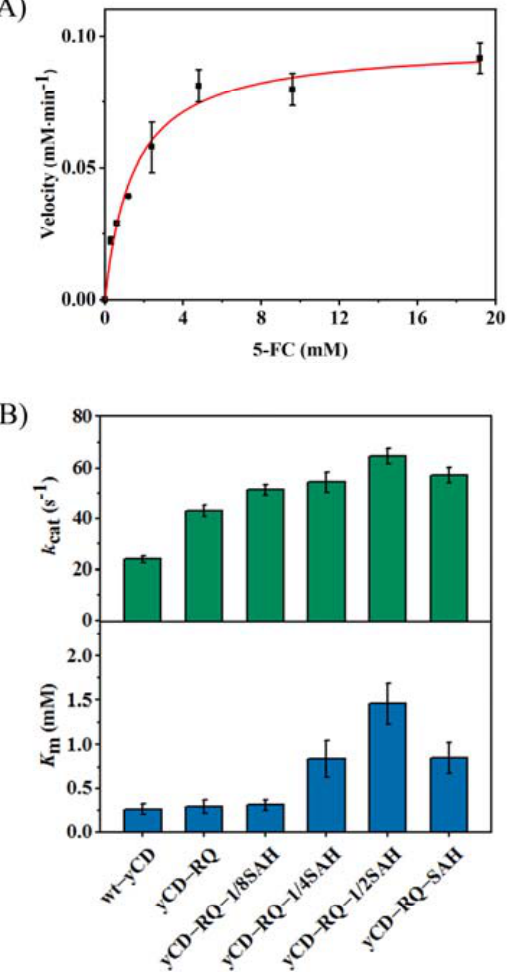
Figure 2. Michaelis − Menten kinetic constants k cat and K m for wt-yCD and its variants on 5-FC catalysis: ( A ) fitting of the Michaelis − Menten equation for the catalysis by yCD-RQ-1/2SAH; ( B ) k cat and K m values of different yCDs. The reactions were carried out at 303 K in 20 mM Tris and 100 mM NaCl, pH 7.0. The error bars are the standard deviation from triple experiments.